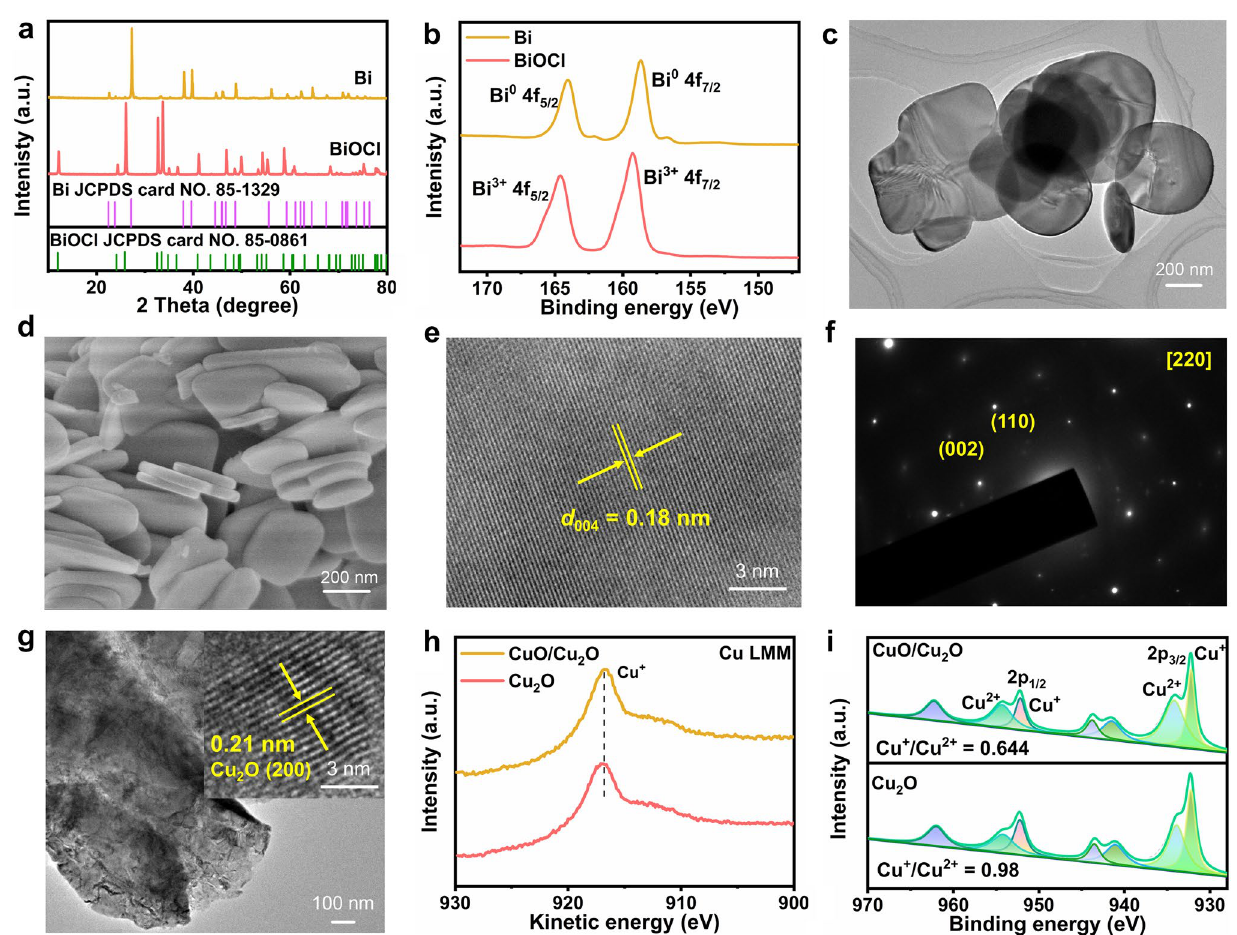
Fig. 1 Morphologies and microstructure of CO 2 RR and FOR catalysts. a XRD pattern, b Bi 4 f XPS spectra of BiOCl and commercial Bi pow- der. c TEM, d SEM, e HRTEM images, f SAED pattern of BiOCl. g TEM and HRTEM images, h Auger Cu LMM, i Cu 2 p spectrum of CuO/ Cu 2 O and Cu 2 O. (Color figure